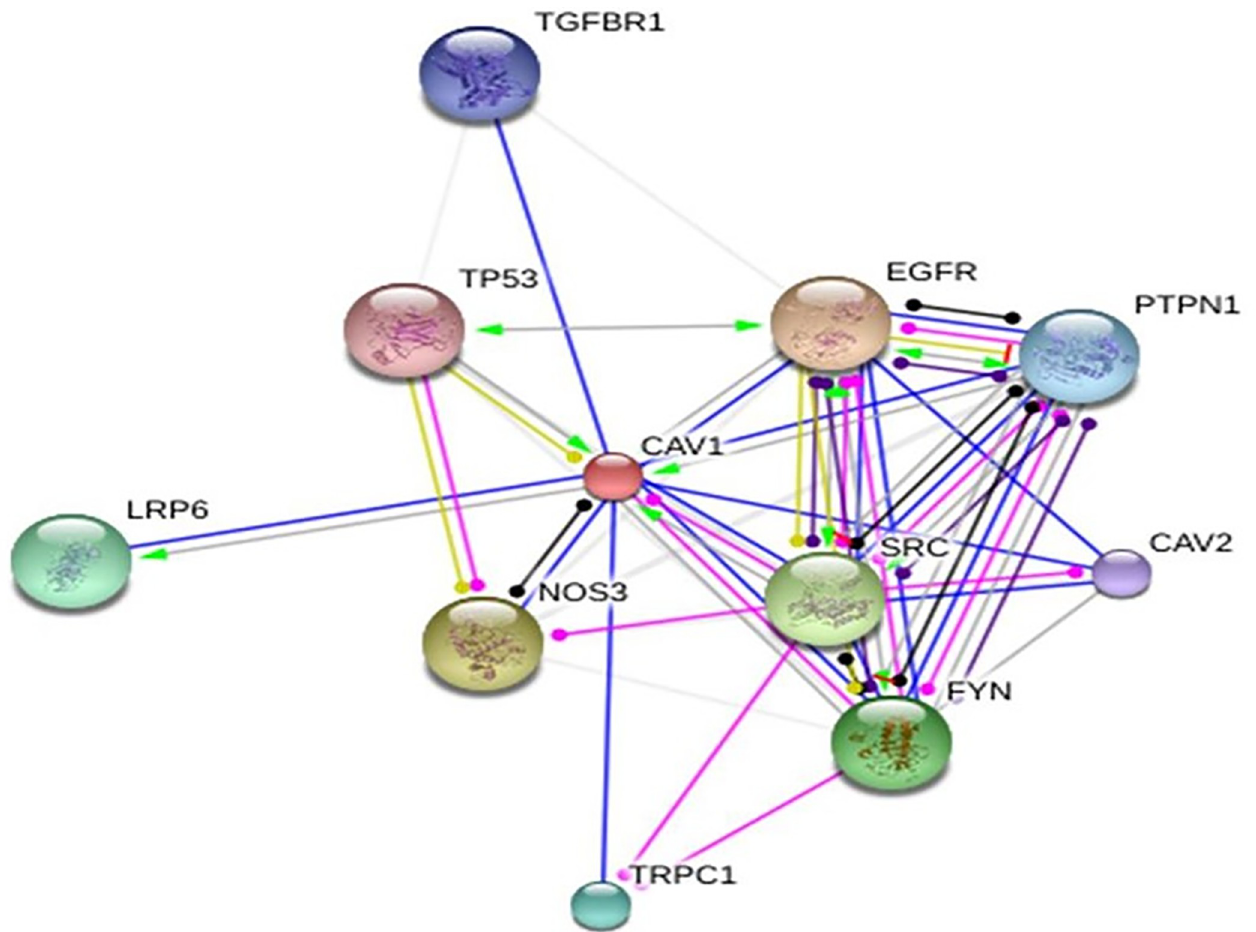
Fig 4. Protein-protein interaction network of human caveolin-1 in A549 radioresistant cells. Network was constructed using STRING 10.0 database. The network shows interaction between Caveolin-1 and other important interacting protein based on experiment, co-expression, text mining & co-expression with 0.007 confidence score as the analysis